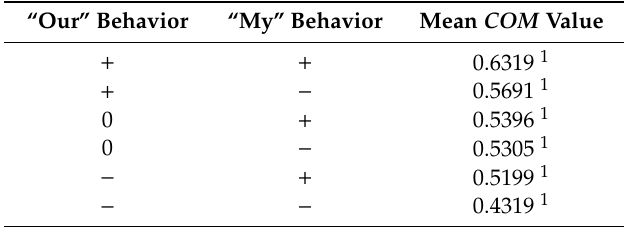
Table 4. COM values with “our” and “my” energy-saving behavior.